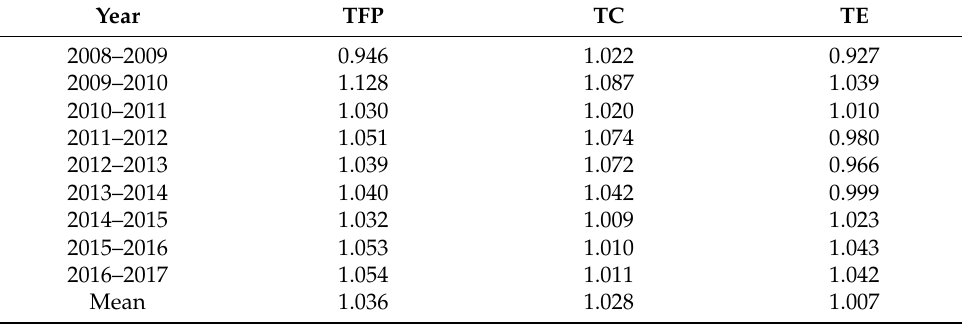
Table 2. ATFP Growth and Decomposition in China from 2008 to